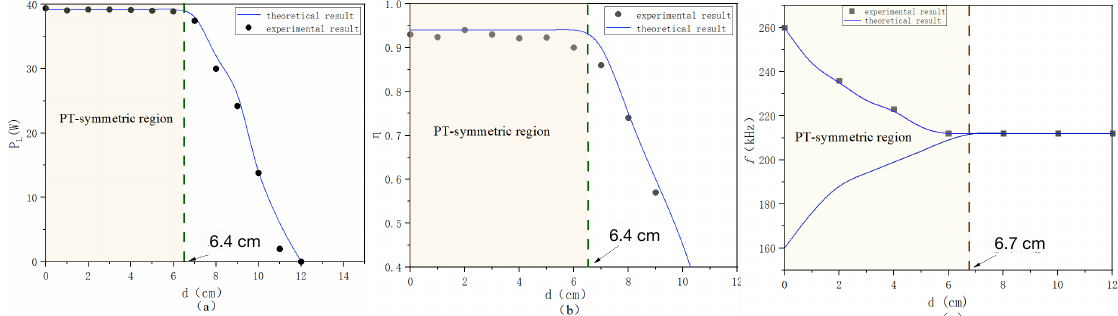
Figure 17. The curves of transmission performance versus transmission distance for case 2: ( a ) output power; ( b ) efficiency; ( c ) operating